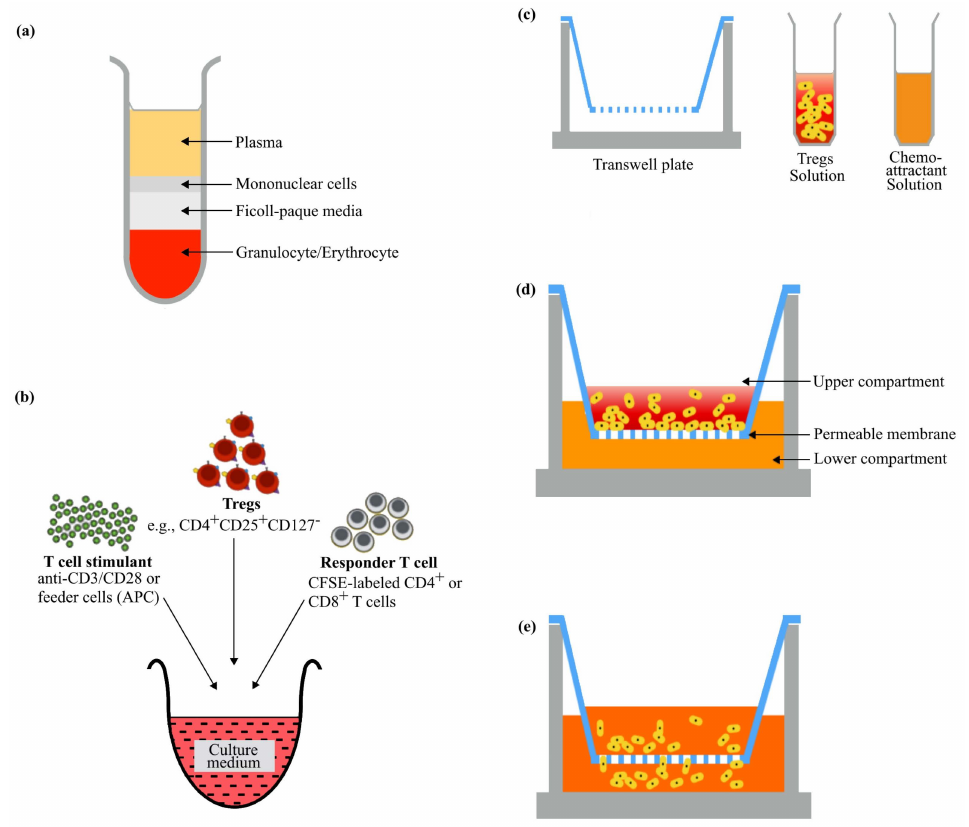
Figure 1. Basic Tregs suppression and transwell migration assay setup. ( a ) Schematic representation of distinct peripheral blood mononuclear cells (PBMC) layer following Ficoll density gradient centrifugation of whole blood. Tregs can be easily enriched from isolated PBMC